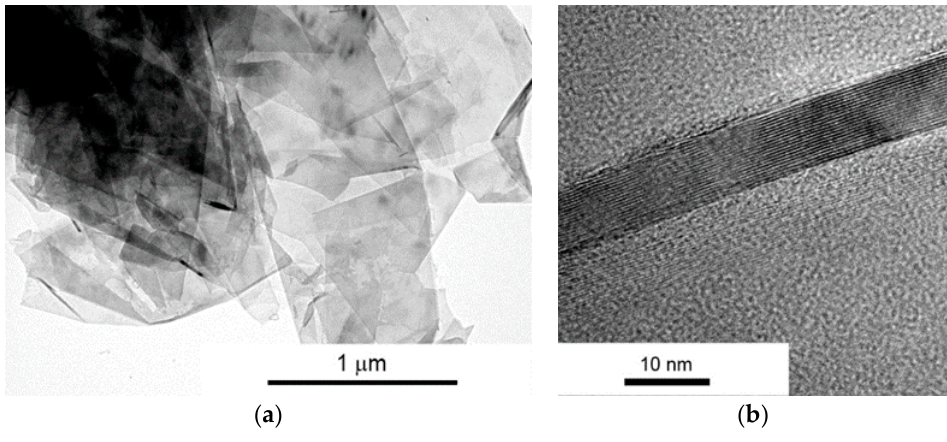
Figure 2. ( a ) STEM and ( b ) HRTEM micrographs of Gn(12) multilayer graphene (MLG) powder.